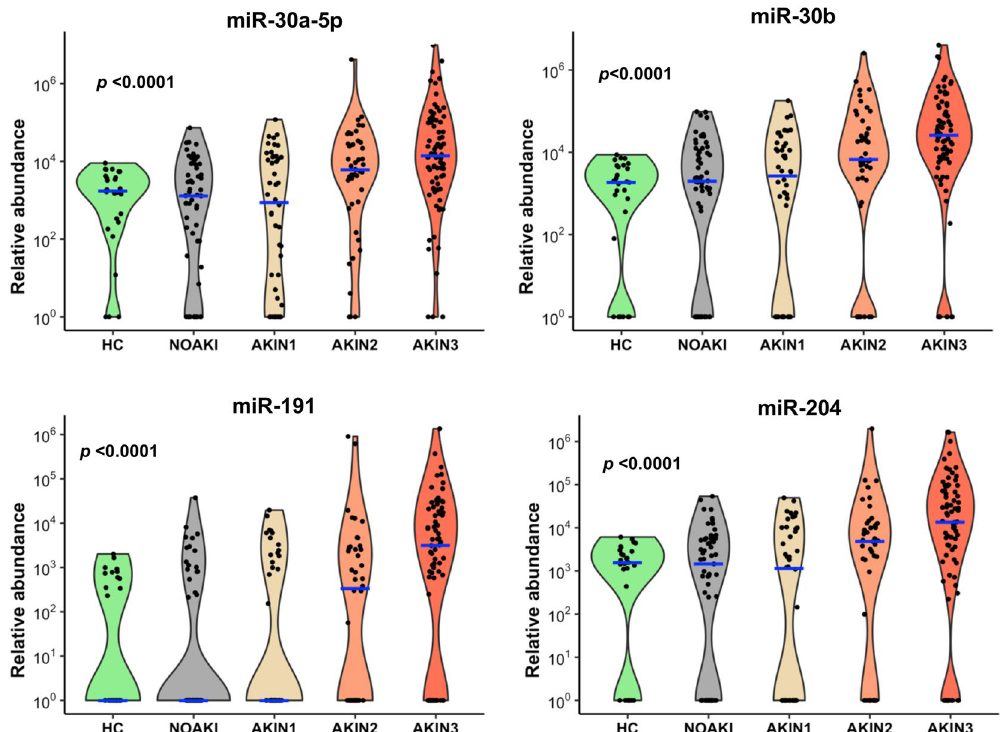
Figure 4. Top four microRNAs associated with AKI for all toxic agents. Violin plots show these microRNAs having increased abundance with increasing AKI severity in all four toxins. Blue lines indicate the medians and each black dot presents a different sample from validation cohort. The y -axis is relative abundance from the detectable limit (2 (39-Ct) , Ct of 39 is the threshold of detectability). MicroRNA expressions were normalised using two spike control ath-microRNAs ( ath -miR-159a and ath -miR-172a). p is the alternative p value from Jonckheere–Terpstra nonparametric ordered